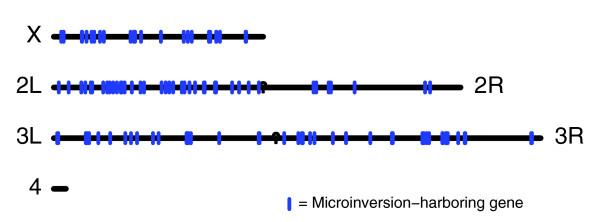
Positions of the 112 microinversion-harboring genes in the D. melanogaster genome. Using data from release 4.2.1 of the D. melanogaster genome assembly, the physical position of each of the 112 microinversion-harboring genes is mapped onto the D. melanogaster chromosomes. The midpoint of each gene is used to map to chromosome. The centromeres for chromosomes 2 and 3 are represented by filled black circles, and the positions of microinversion-harboring genes are indicated by vertical blue lines.